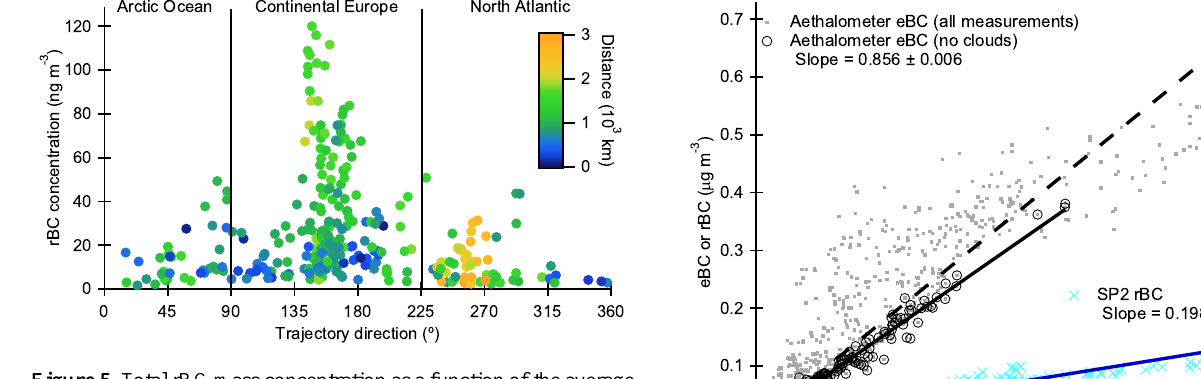
Figure 5. Total rBC mass concentration as a function of the average trajectory direction. Color scale indicates the average distance of the trajectory coordinate points from Pallas.